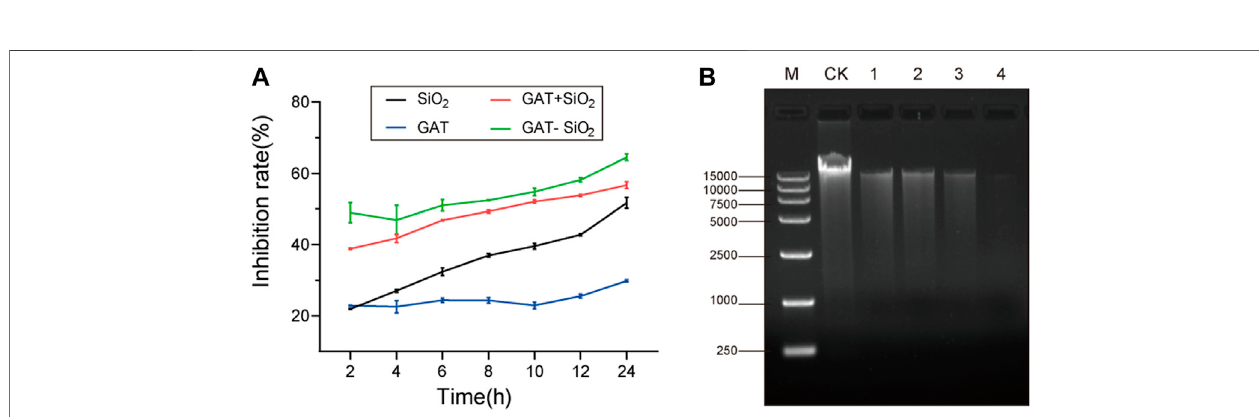
FIGURE3|(A) Bacteriainhibitiverateongati fl oxacin,SiO 2 NPs,gati fl oxacinand silicasimplemixture, andGAT-SiO 2 NPs. (B) Agarose gelelectrophoresisimages of DNA extracted from different treatments of E. coli . CK: intact E. coli cells. (1): treated with SiO 2 NPs; (2): treated with gati fl oxacin; (3): treated with a mixture of gati fl oxacin and silica; (4): treated with GAT-SiO 2